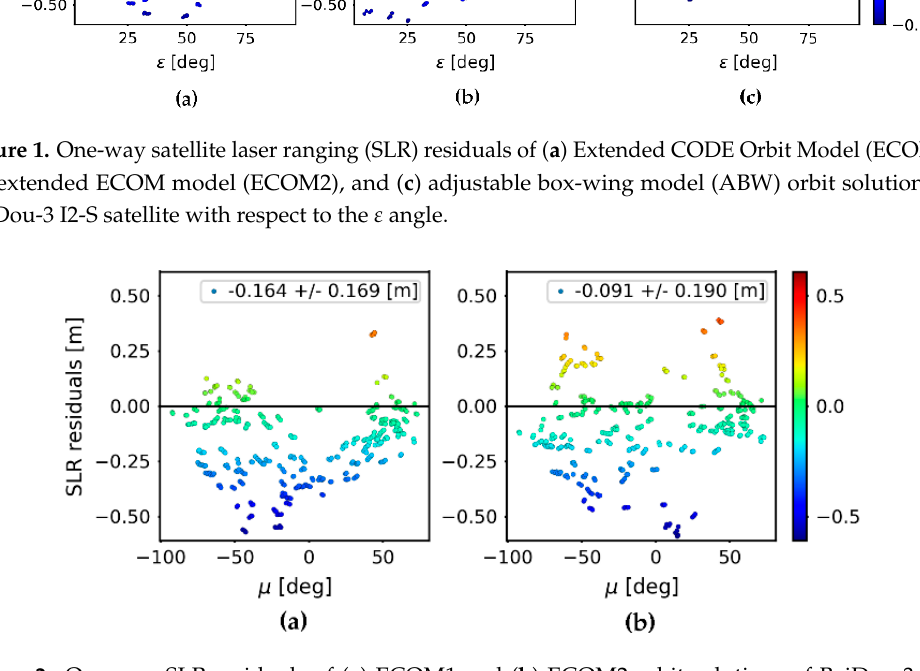
Figure 2. One-way SLR residuals of ( a ) ECOM1 and ( b ) ECOM2 orbit solutions of BeiDou-3 I2-S satellite with respect to the μ angle.